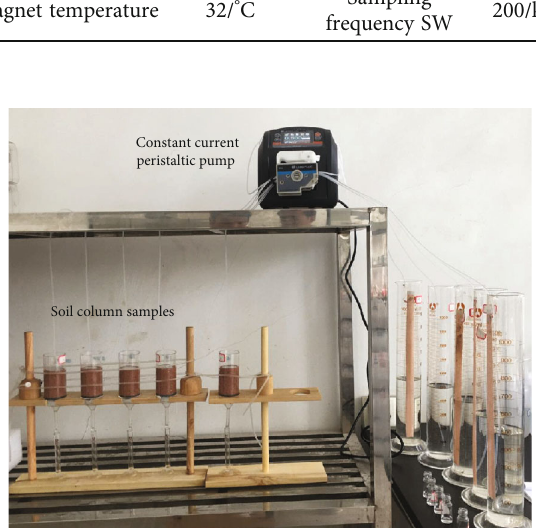
Figure 4: Indoor leaching